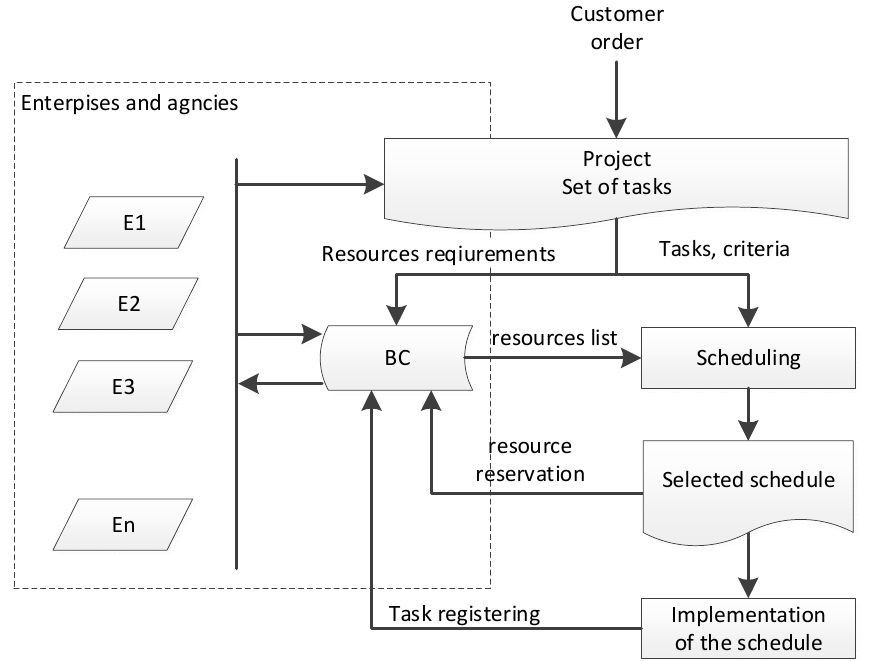
Figure 13. Production scheduling process with the use of BC technology to manage employee competencies.